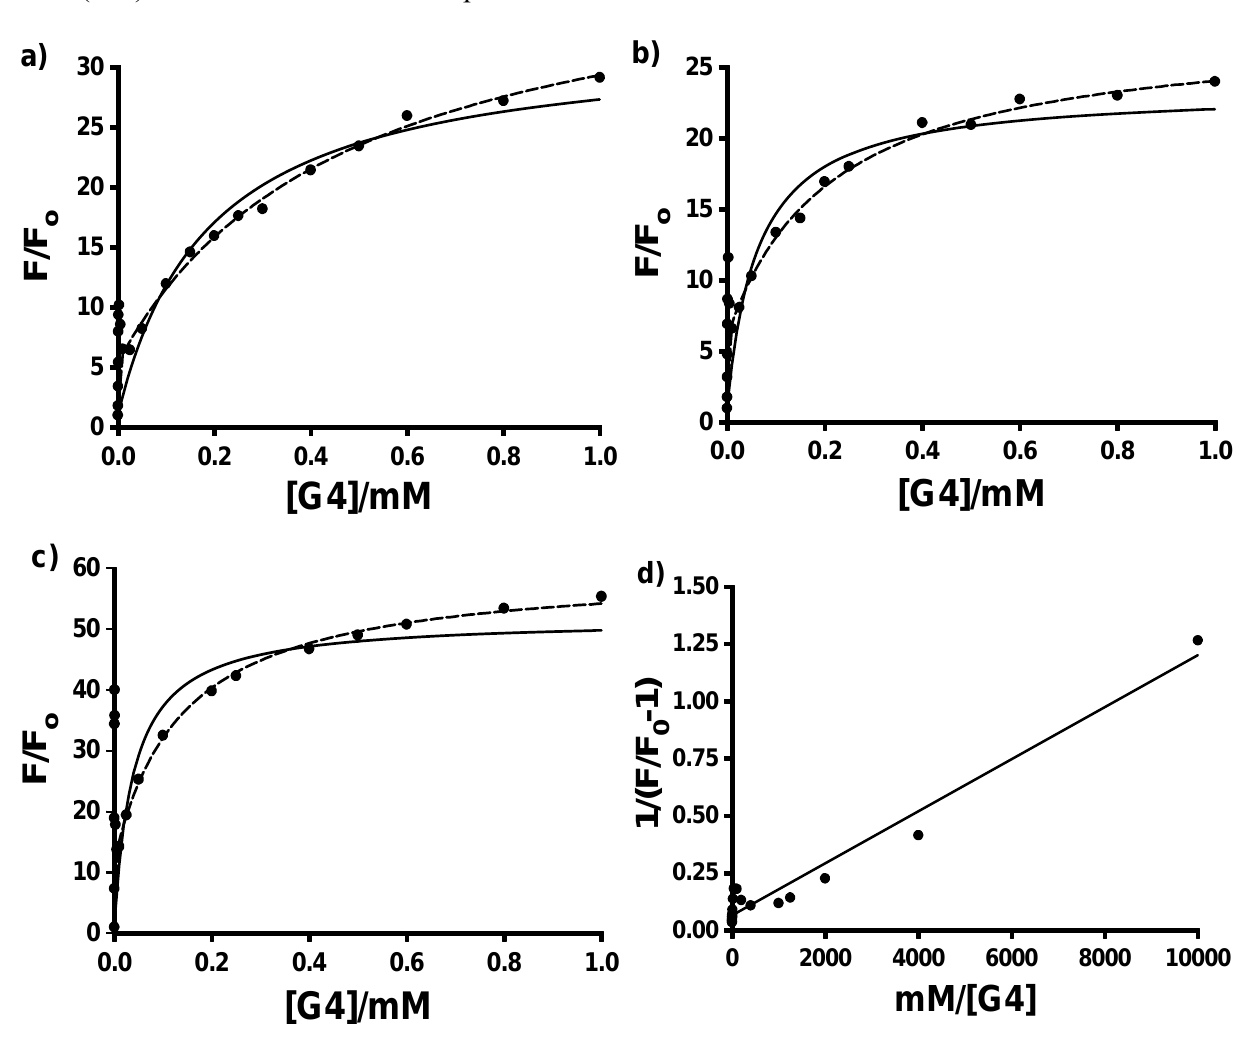
Figure 4. Averaged host fluorescence titration plots for 4 × 10 -5 M a) 1,8-ANS; b) 2,6-ANS and c) 2,6-TNS as function of PAMAM dendrimer G4 concentration. The double reciprocal plot for 1,8-ANS in G4 is shown in d). The fits to the 1:1 (  ) and 2:1 (- - -) models are also shown in parts a to